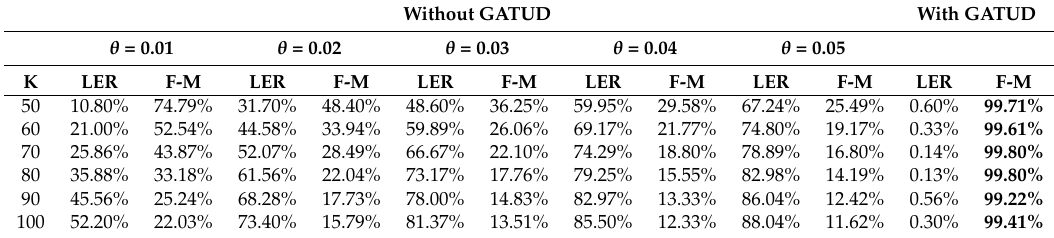
Table 19. The detection accuracy of k -means clustering algorithm with/without GATUD on SimData2. Without GATUD With GATUD θ = 0.01 θ = 0.02